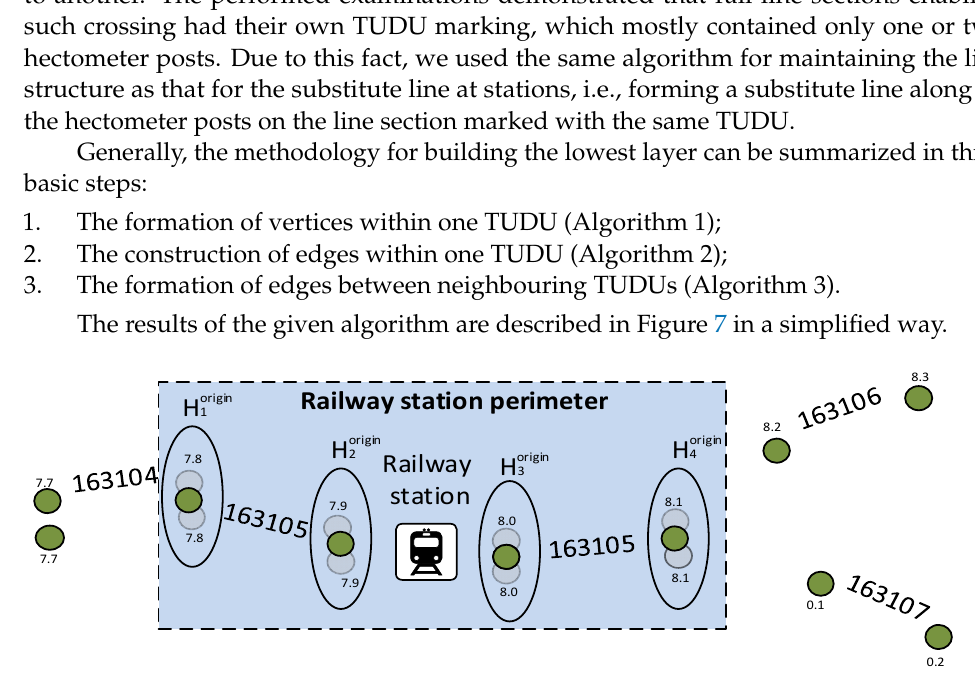
Figure 6. Sample construction of substitute hectometer posts. Author ´ s resource. Algorithm 1. Formation of a vertex set within individual TUDUs.